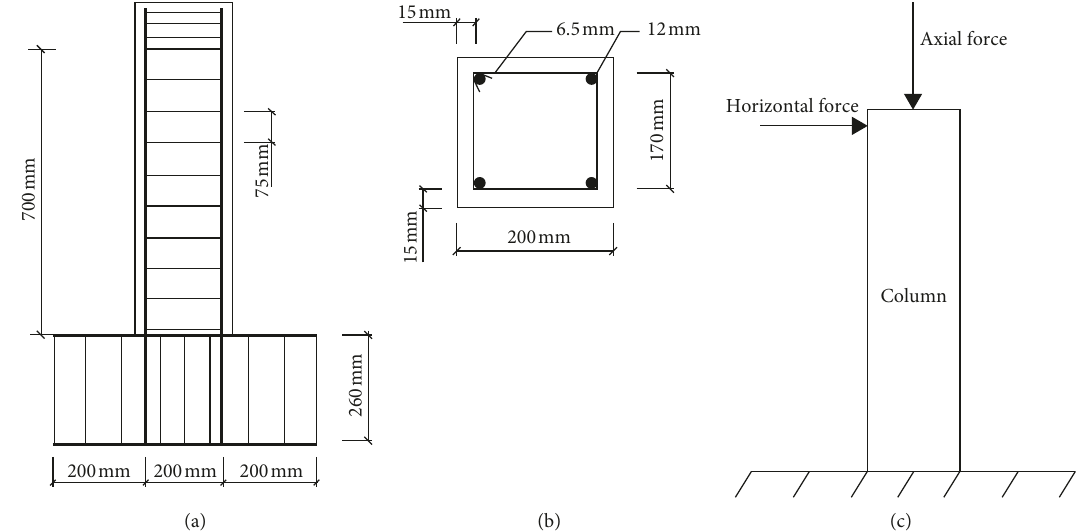
Figure 3: Specimen construction, reinforcement, and loading. (a) Dimensions. (b) Bar arrangement. (c) Loading.